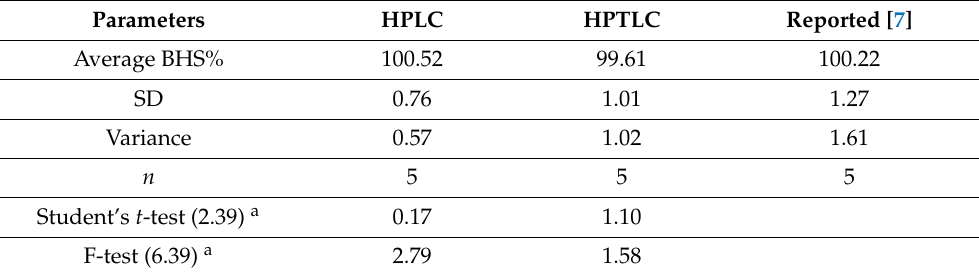
Table 4. Statistical comparison between the results obtained by the proposed chromatographic methods and the reported method for the determination of BHS in Betaserc ®